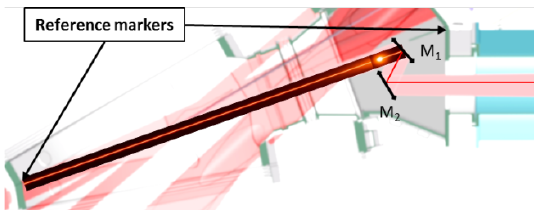
Fig. 12. Alignment set-up with a cross laser suspended on the innermost rail. Alignment order: laser, M1 position M2 position, M1 angle, M2